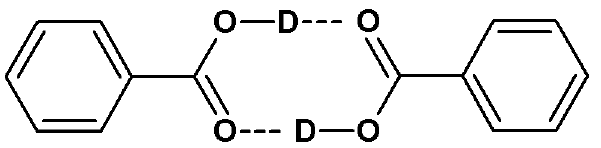
Figure 4. Dimerised form of isotopically neat benzoic acid.